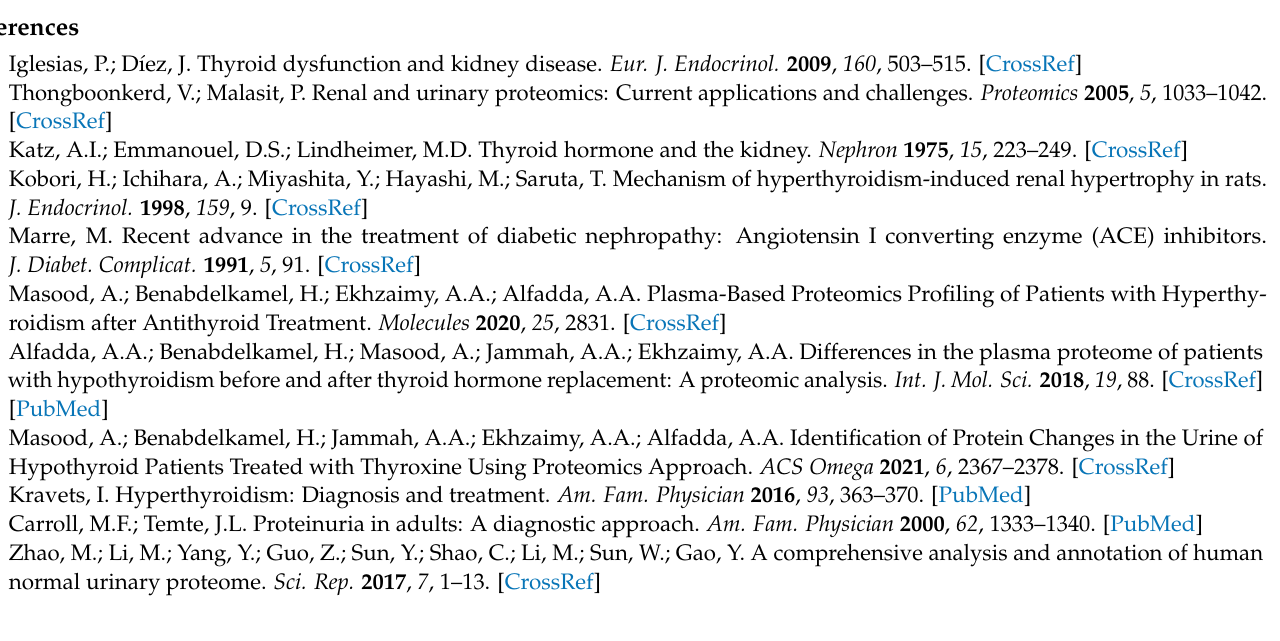
Canonical pathways, Table S1: Experimental design, Table S2: Mass spectrometry list of significant differentially abundant